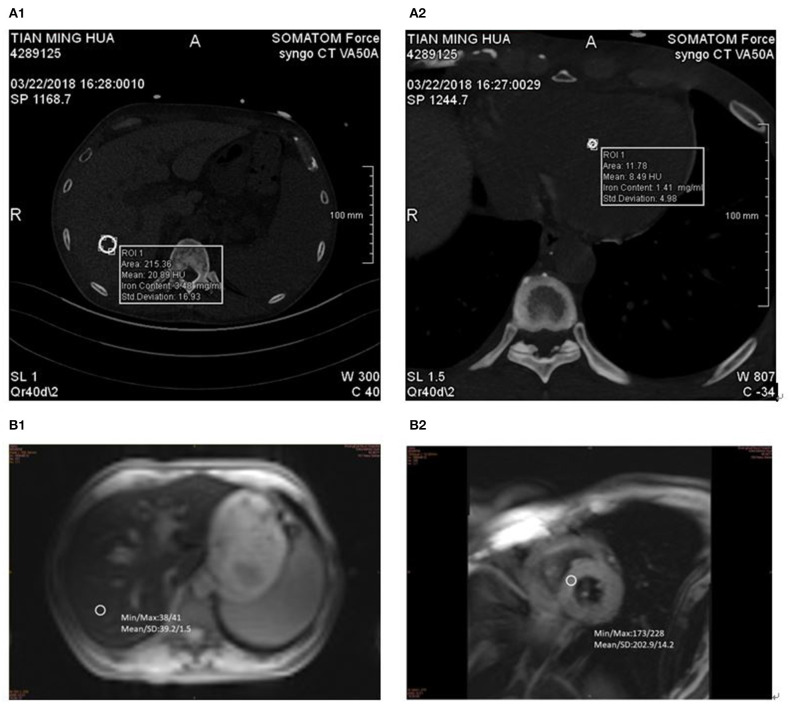
DECT and MR measurements in 57-year-old man with MDS-RS. ASF 5,807 ng/ml. (A1) liver VIC 4.67 mg/ml and (A2) cardiac VIC 6.83 mg/ml. (B1) LIC 11.2 mg/g and (B2) MIC 7.2 mg/g.